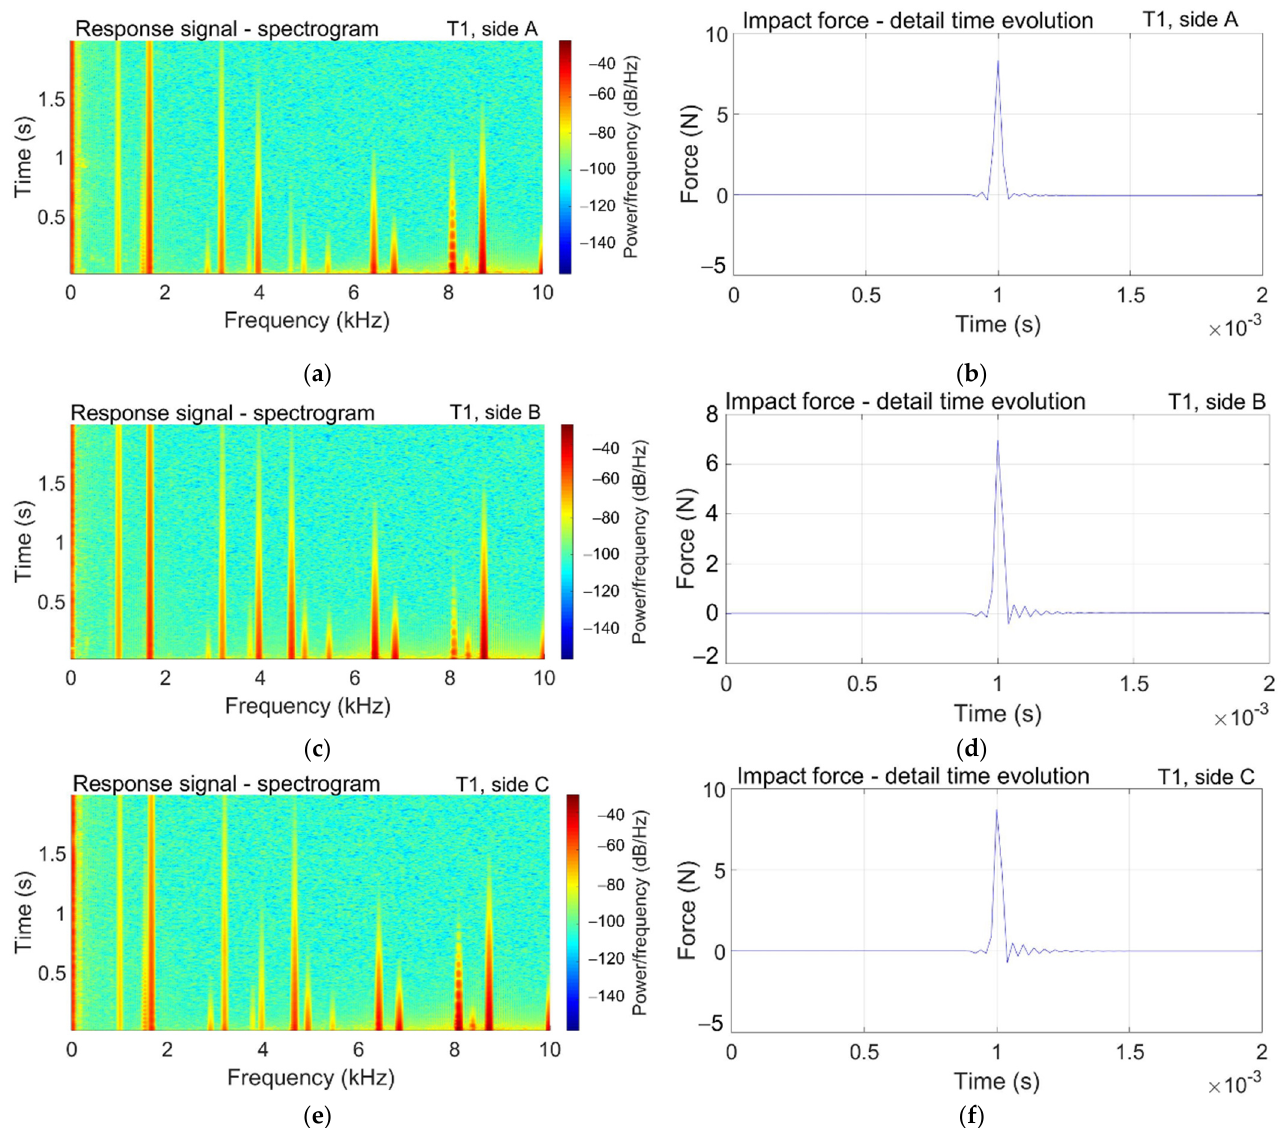
Figure 6. The spectrograms and the graphs of impact force, for stainless steel triangle T1: ( a ) in case of excitation of side A; ( b ) the plot of excitation force against the time, by hitting side A; ( c ) in case of excitation of side B; ( d ) the plot of excitation force against the time, by hitting side B; ( e ) in case of excitation of side C; ( f ) the plot of excitation force against the time, by hitting side C. Since the experimental results do not provide information about the vibration modes of the triangles, the finite element analysis completes these data, especially since the results obtained by the two methods are in good